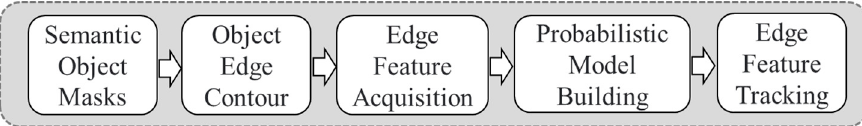
Algorithm 2: Outlier elimination algorithm of dynamic noise tracking.